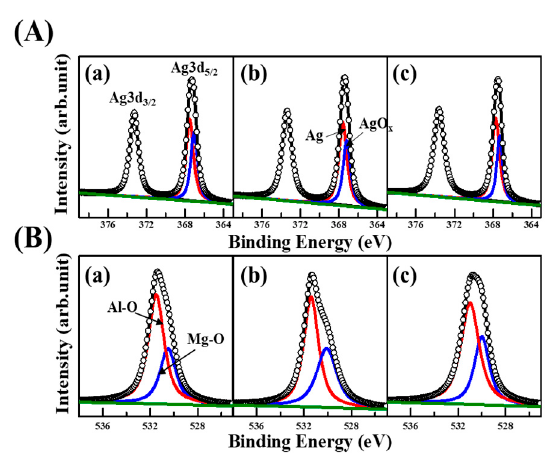
Figure 5. X-ray photoelectron spectroscopy (XPS) of ( A ) Ag 3d and ( B ) O 1s electrons for ( a ) Ag@LDO400, ( b ) Ag@LDO500, and ( c ) Ag@LDO600. Black line: observed spectrum, open circles: summation of separated peak, red line: Ag(0) or Al-bound O, blue line: oxidized Ag or Mg-bound O, green line: background for peak separation.